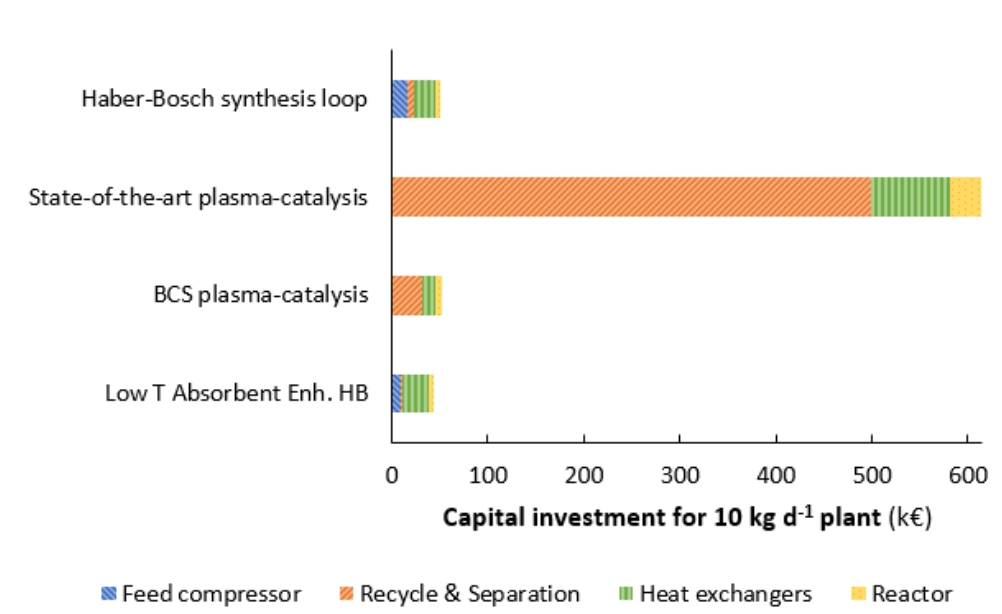
Figure 8. Capital investment for the conventional Haber-Bosch synthesis loop, state-of-the-art plasma catalysis, a best-case scenario for plasma catalysis, and an absorbent-enhanced Haber-Bosch synthesis loop at 10 kg t-NH 3 d − 1 (~10 kW). Estimates for the conventional Haber-Bosch synthesis loop and the absorbent-enhanced Haber-Bosch synthesis loop are based on [67]. The cost of the plasma reactor is assumed to be the combination of a conventional reactor and a plasma generator source. A cost-scaling factor of 0.6 is used for scale-down of equipment. See also Table 3.